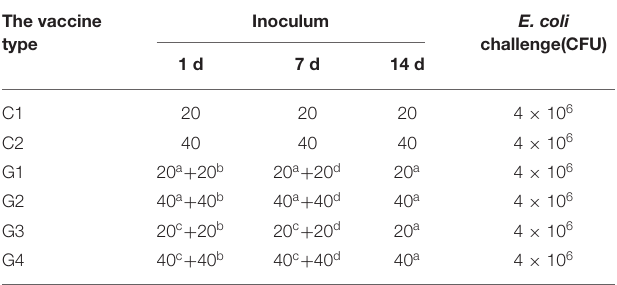
TABLE 3 | Vaccine immunogenicity and E. coli